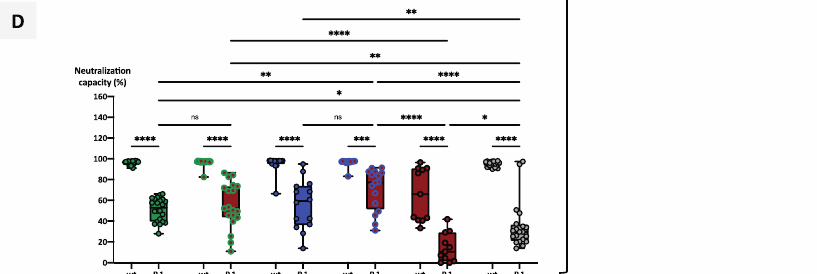
Figure 5. Impact of vaccination regimes on the neutralizing capacity against variants of concern. Serum samples from 23 subjects after homologous vaccination with BNT162b2, 23 subjects after heterologous vaccination with ChAdOx1/BNT162b2, 23 subjects after homologous vaccination with mRNA-1273, 23 subjects after heterologous vaccination with ChAdOx1/mRNA-1273, and 11 subjects after homologous vaccination with ChAdOx1 were collected 2 weeks after their second vaccinations. Serum samples from 20 unvaccinated COVID-19-convalescent individuals, collected at a median time of 14 weeks after diagnosis, served as control cohort. Samples were analyzed for neutralization capacity against wildtype RBD and three RBD variants of concern. Boxplots in panel ( A ) summarize neutralization capacities in the five vaccination cohorts and in an unvaccinated COVID-19-convalescent cohort. ( B – D ) Boxplots show neutralization capacities against wildtype RBD and ( B ) the B.1.1.7 RBD variant, ( C ) the B.1.351 RBD variant, and ( D ) the P.1 RBD variant. Box central horizontal lines indicate medians, box borders represent IQR, and whiskers represent minima and maxima. Significance levels were tested by Šídák’s test for multiple comparisons, with * p < 0.05, ** p < 0.005, *** p < 0.0005, and **** p < 0.00005. Abbreviations: IQR: interquartile range; ns: not significant; RBD: receptor-binding domain.